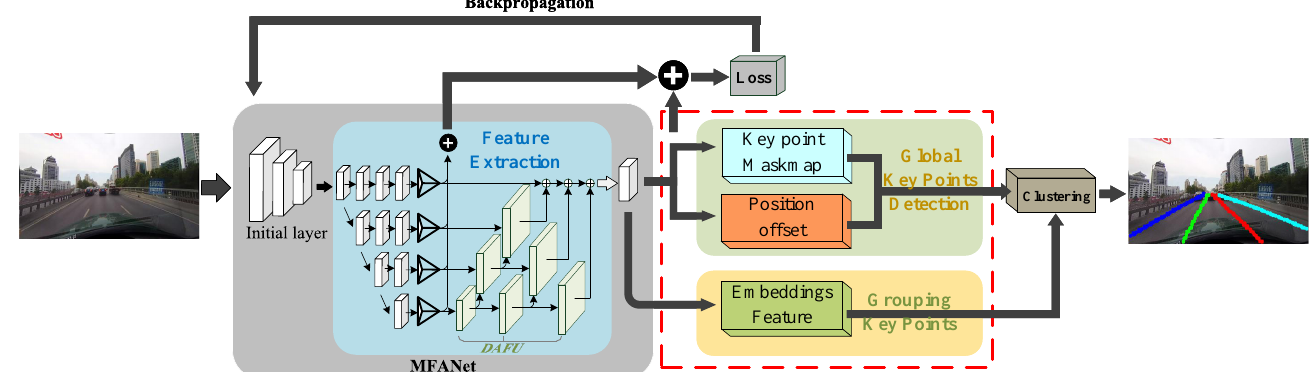
Figure 2. Overview of the proposed method. MFANet incorporates DAFU and generates two sets of prediction from the input images. Subsequently, the key points of global lane line can be accurately conjectured base on these resulting prediction sets. Finally, association embedding strategy is utilized to make the final local geometry of lane curves.